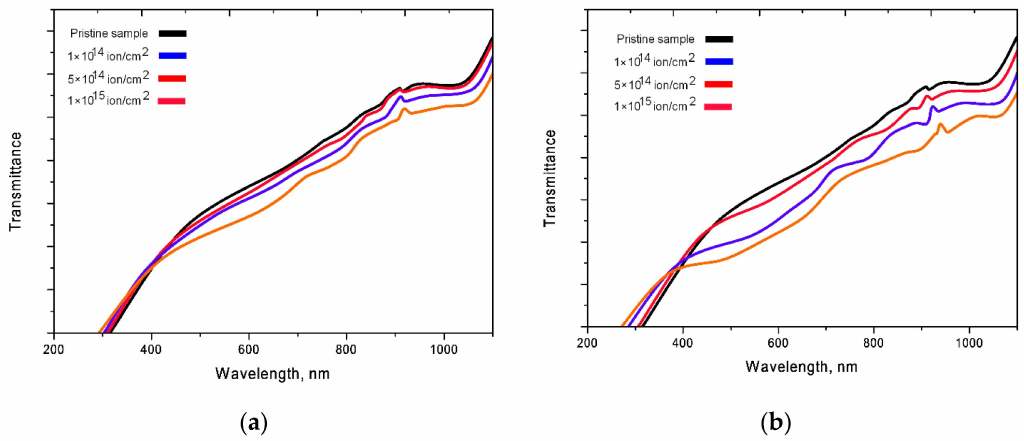
Figure 4. UV–visible transmittance of AlN ceramic: ( a ) Kr 15 + ion irradiated dose; ( b ) Xe 22 + ion irradiated